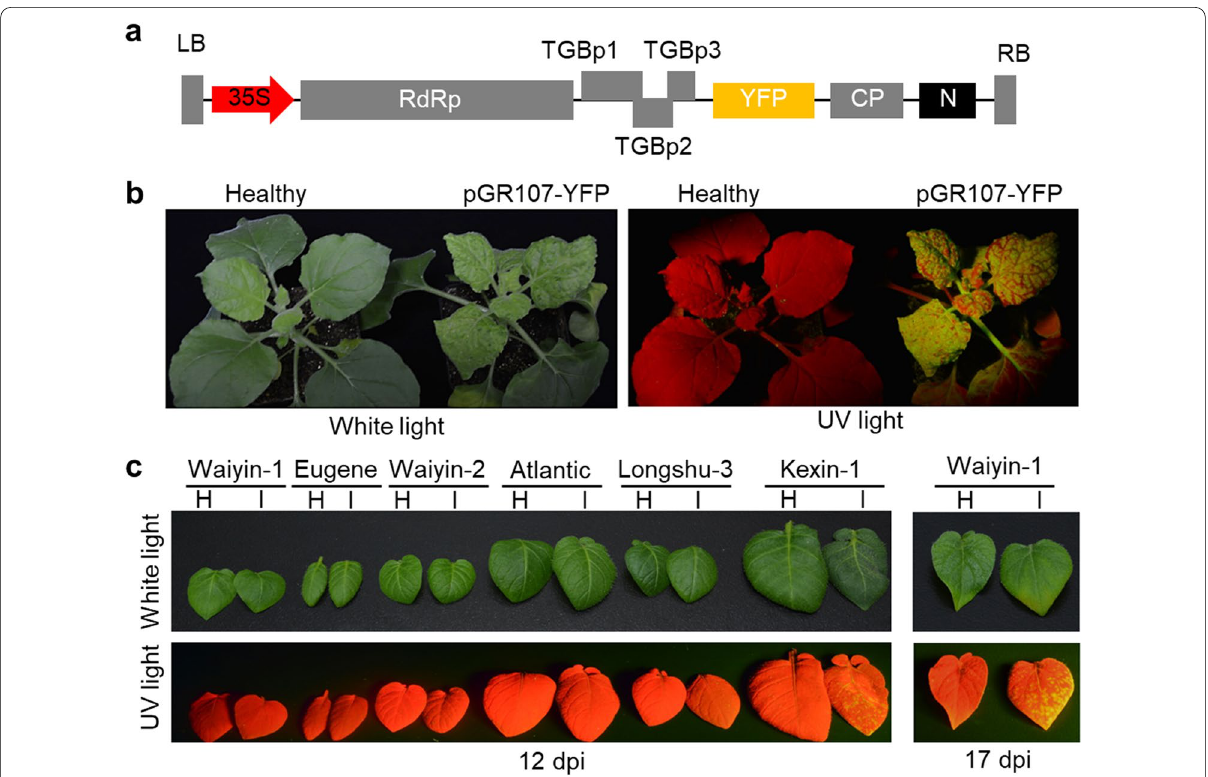
Fig. 2 Evaluation of the resistance of potato cultivars using a YFP-tagged PVX infection clone. a Diagram illustration of pGR107-YFP. LB and RB are left and right T-DNA border, respectively. 35S, cauliflower mosaic virus (CaMV) 35S promoter; N, NOS terminator; RdRp, RNA-dependent RNA polymerase; CP, coat protein. b Symptoms of N. benthamiana infected with pGR107-YFP under white (left panel) and UV light (right panel) at 7 dpi. c Symptoms on systemic leaves of potato plantlets infected with pGR107-YFP under white and UV light at 12 and 17 dpi. H, healthy control; I, PVX-infected